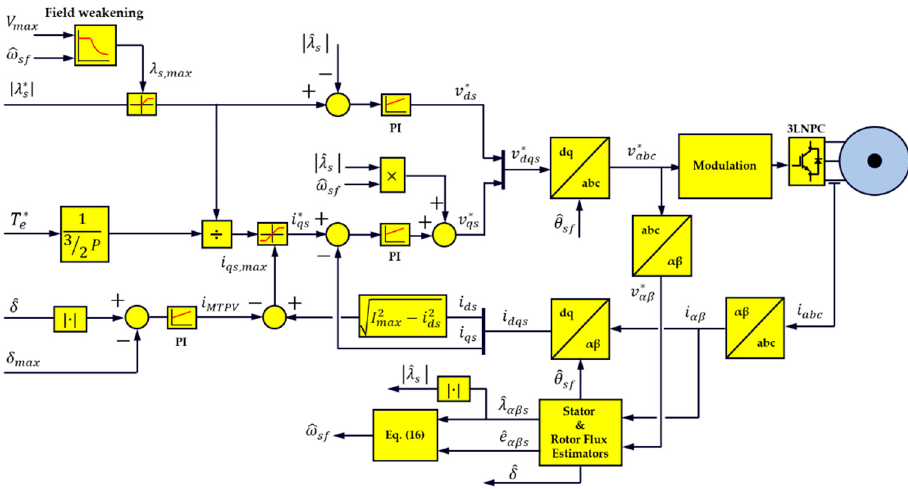
Figure 10. Direct Flux Vector Control (DFVC) scheme.